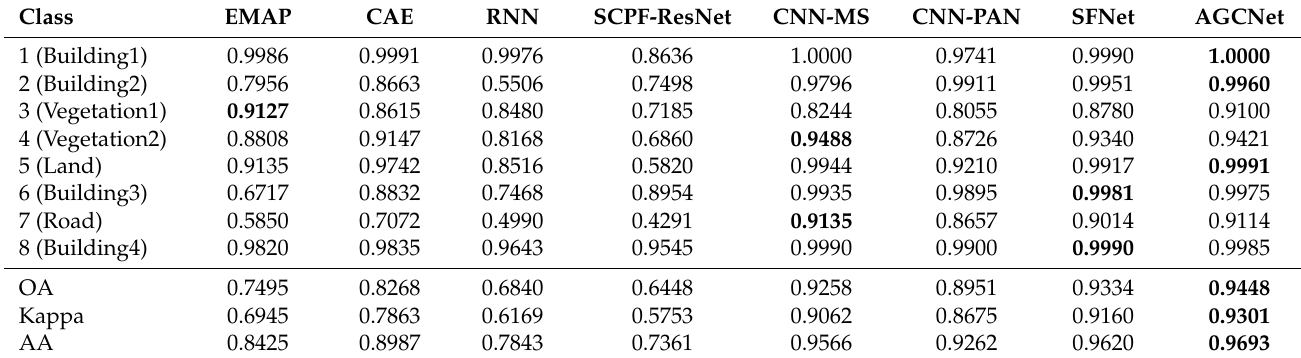
Table 4. Classification accuracy on Xi’an Suburban dataset.